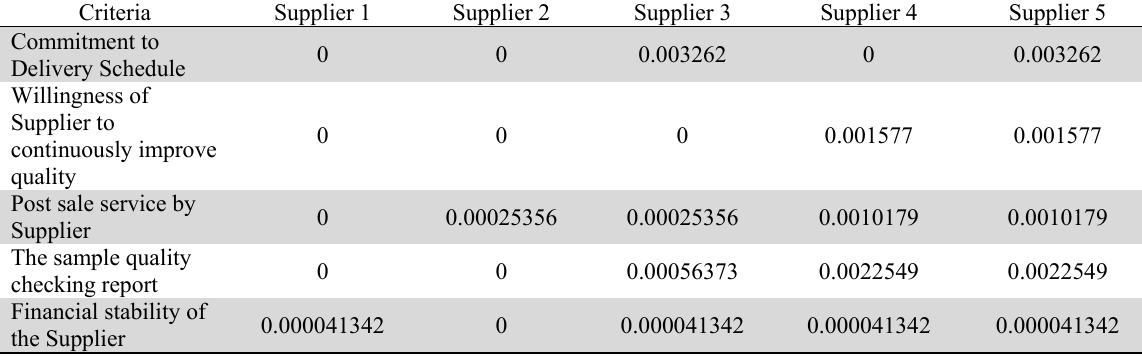
Separation from the ideal solution